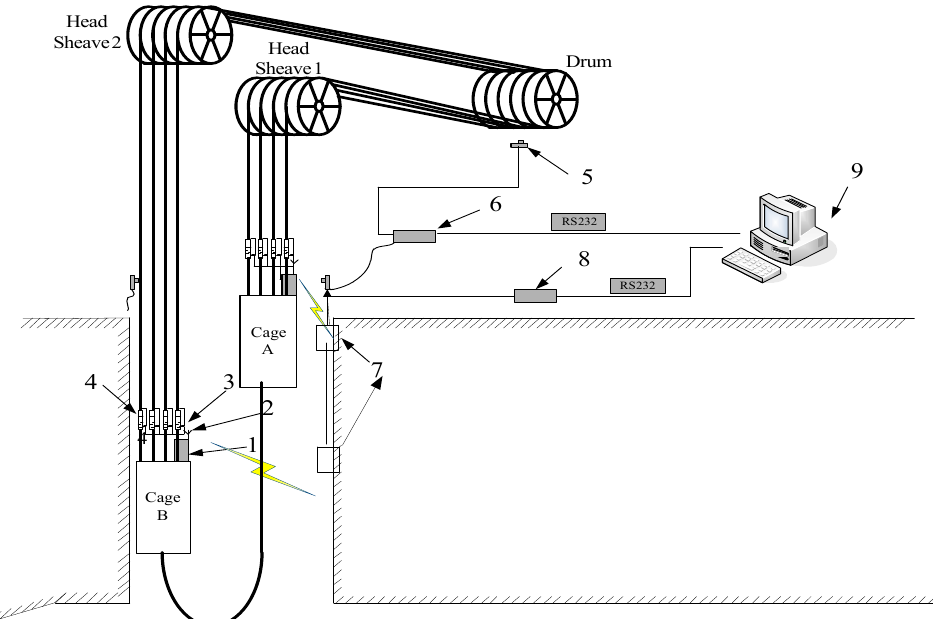
Figure 1. Schematic of tension monitoring system for multi-rope hoist. 1—Data acquisition module;